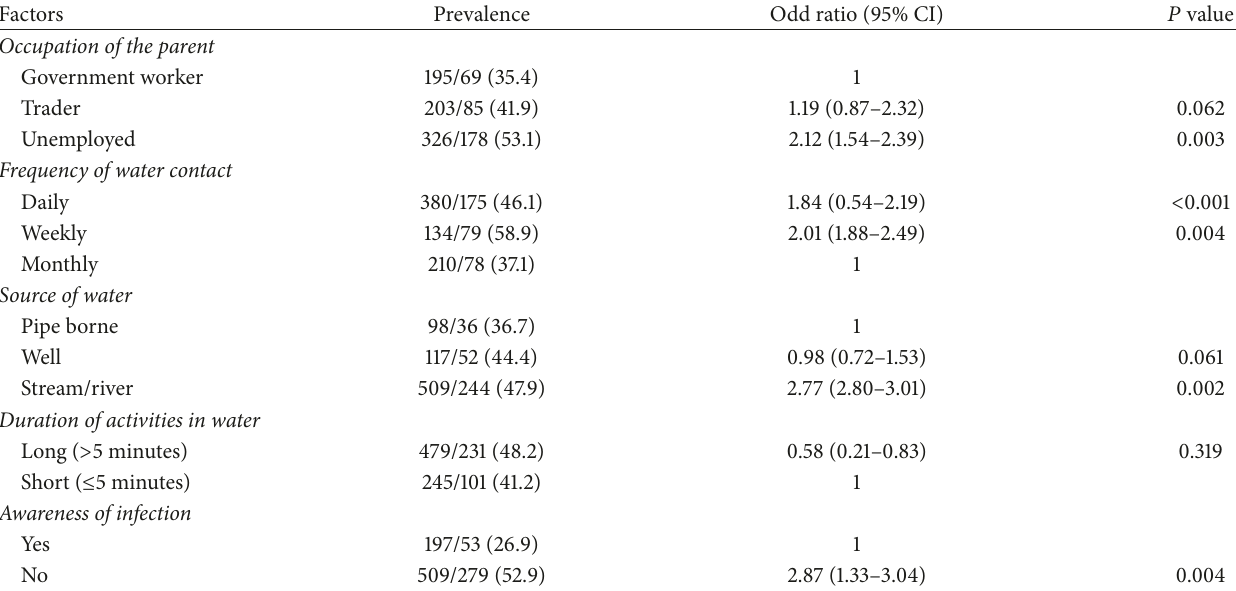
Table 4: Univariate analysis of epidemiological factors for urinary schistosomiasis in the study area.